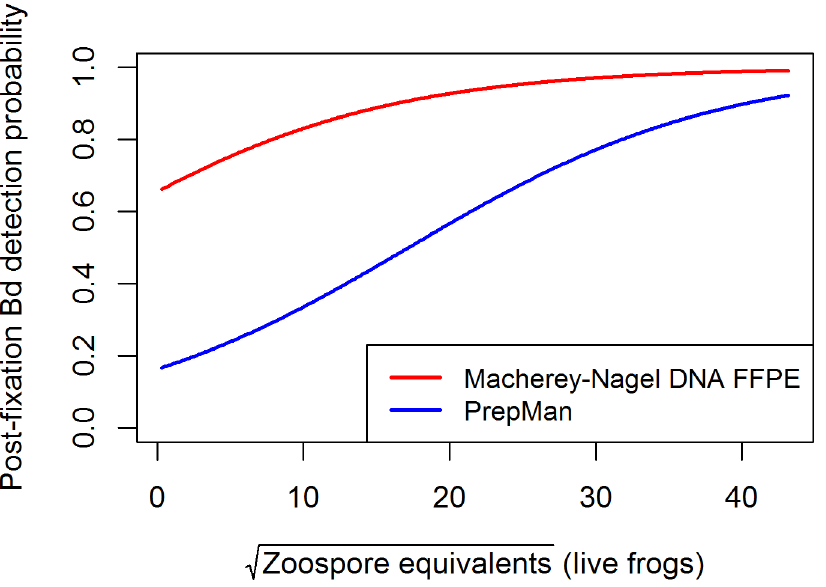
Fig 2. Probability of Batrachochytrium dendrobatidis (Bd) detection after formalin fixation. We used parameters from the best-fit generalized linear mixed models (Table 3) to predict Bd detection probabilities of the two different extraction methods, Macherey-Nagel DNA FFPE (MN), and PrepMan (PM). The differences in Bd detection probability between MN and PM are greatest at low and moderate Bd loads (as much as 50% at the median infection level of this study) and become more similar at higher Bd